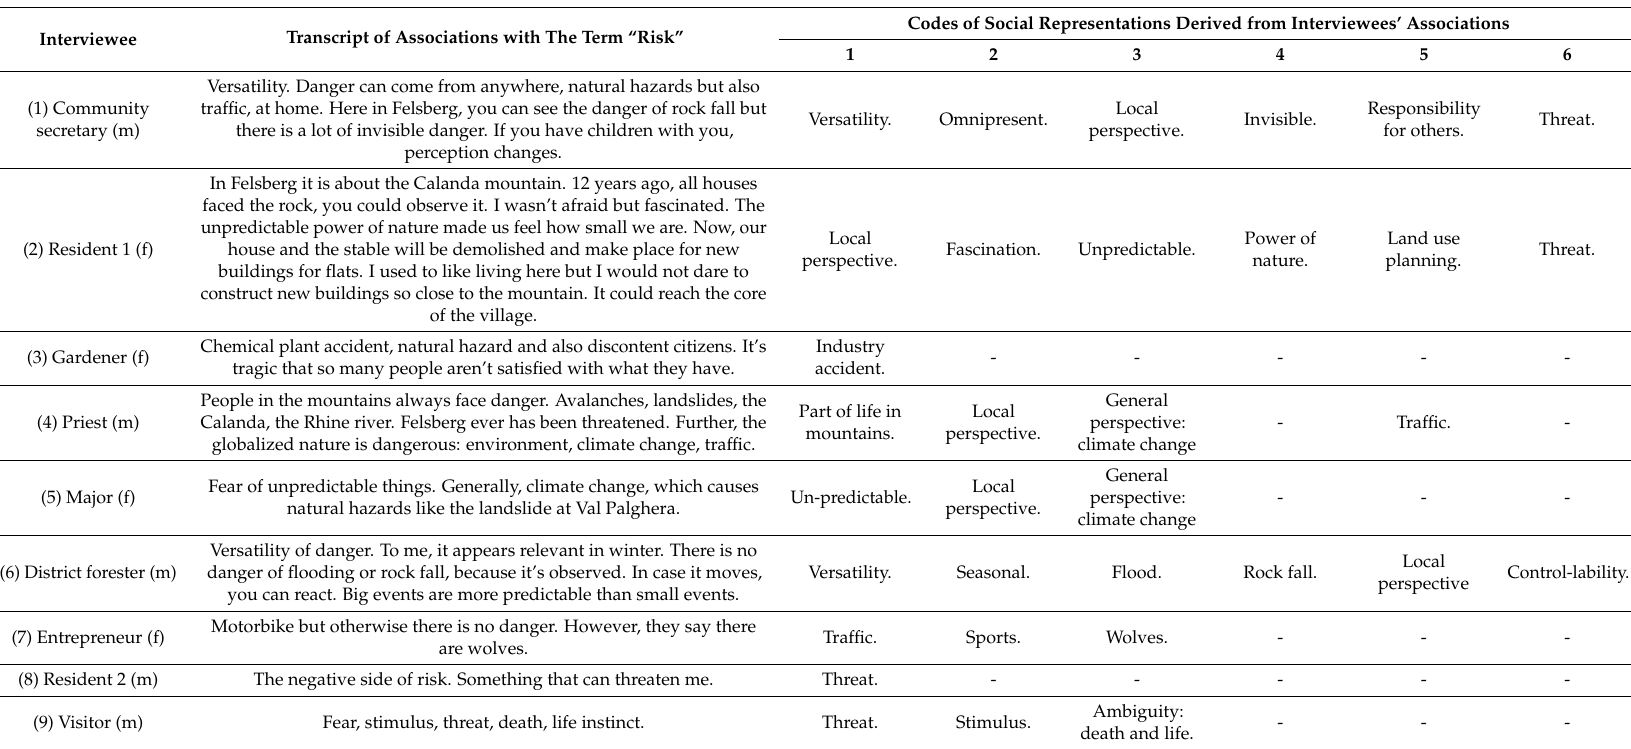
Table 4. Social representation of danger in